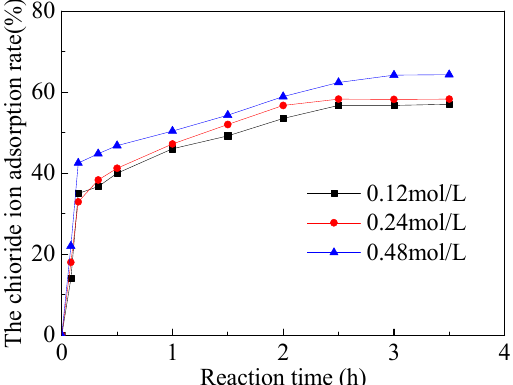
Figure 2. Effect of contact time on the adsorption of Cl − onto the CaAl-Cl LDH precursors with [Cl − ] = 0.12 mol/L, 0.24 mol/L and 0.48 mol/L.